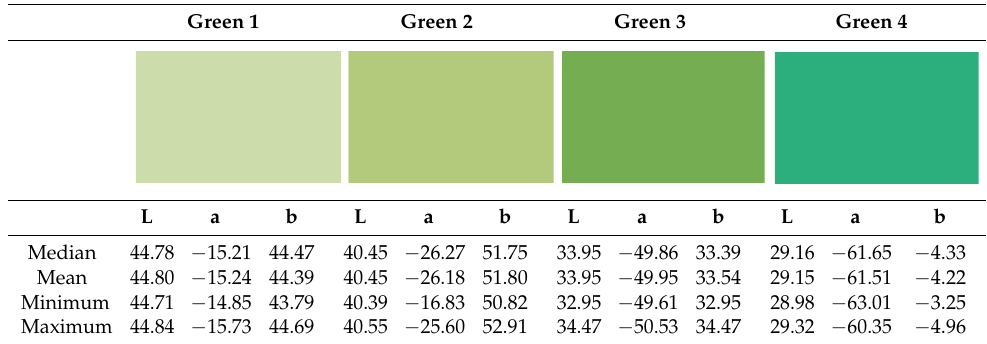
Figure 6. Reflection of paved ground with different colored cards, ∆E, ∆L, ∆a, ∆b and the defined threshold for detection.